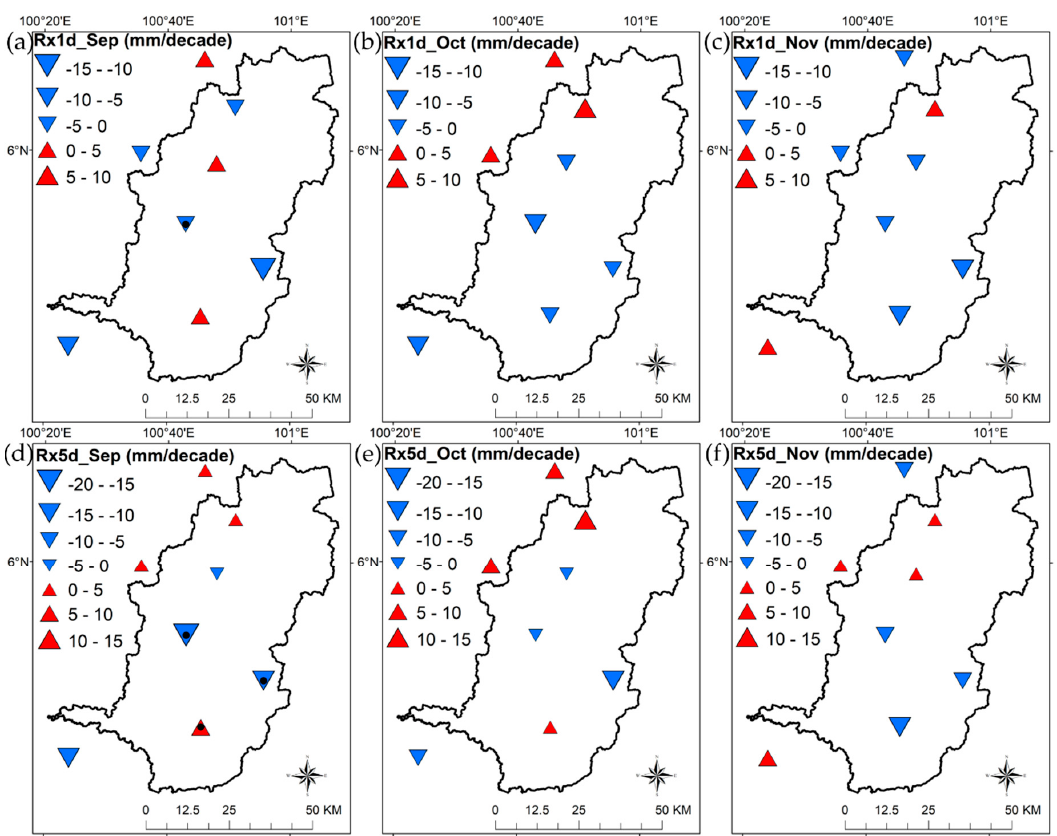
Figure 6. Trend for regionally averaged Rx1d and Rx5d indices over the Muda River Basin during 1985–2015. Dotted indicates significant trend at a 95% significance level. ( a ) Rx1d–September; ( b ) Rx1d–October; ( c ) Rx1d–November; ( d ) Rx5d–September; ( e ) Rx5d–October; ( f ) Rx5d–November.